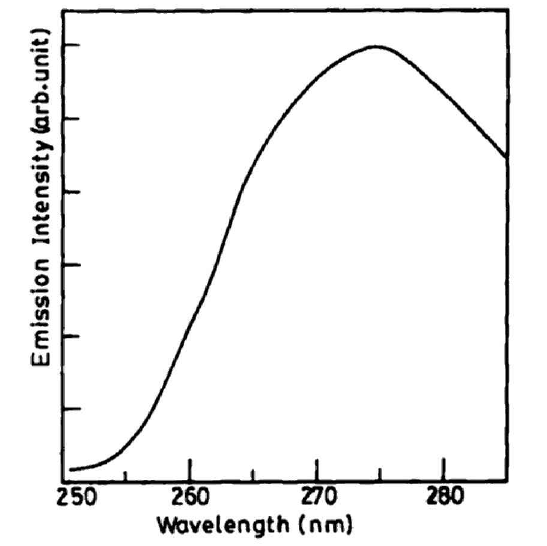
Fig. 4 Excitation spectra of the trimer, T, in TFA at 293K registered at 380nm ( ¶ trimer in TFA at